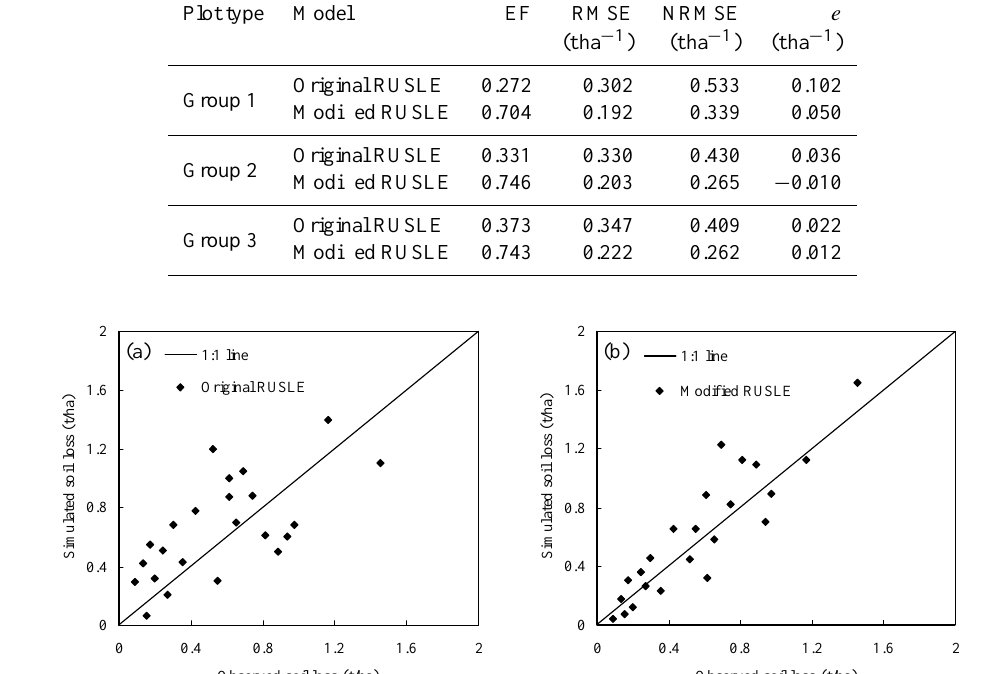
Table 5. Values of model performance evaluation criteria to predict event soil loss of the three runoff plot groups.